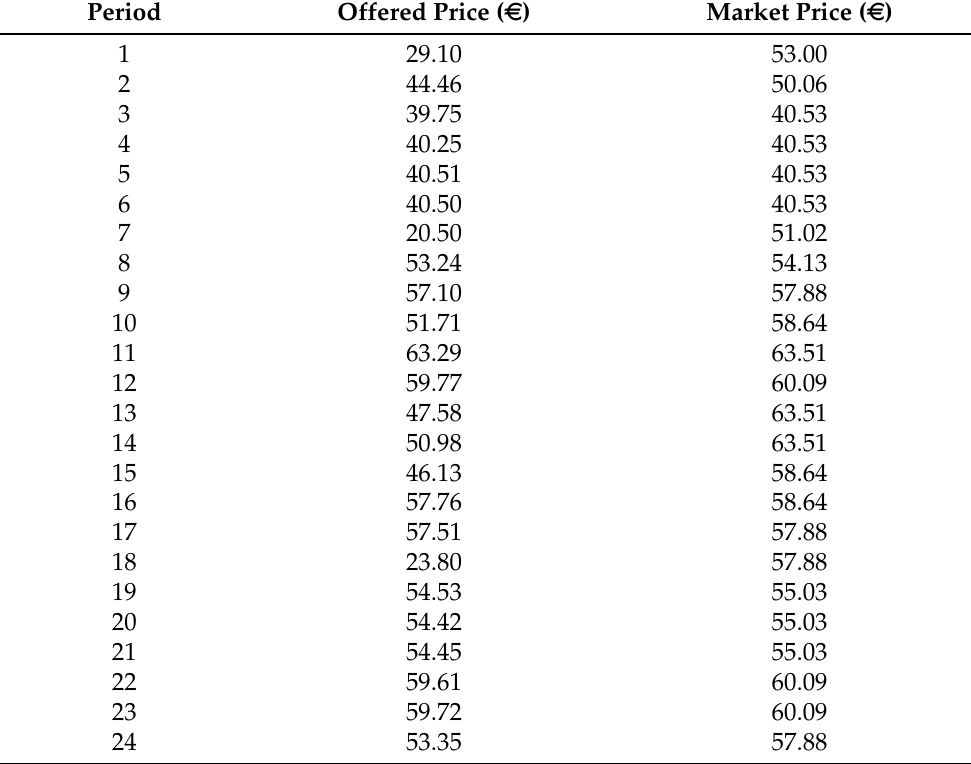
Table 9. Comparison between the price offered by Player 56 and the market